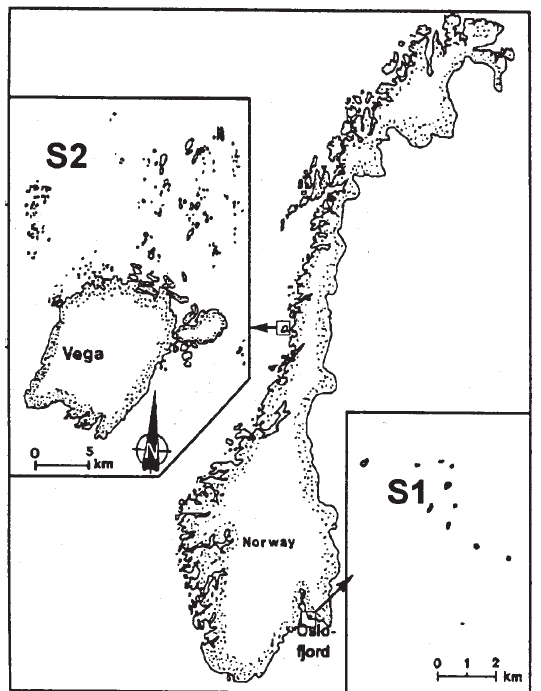
Fig. 2 . Sampling sites at Hvaler in the eastern outer Oslo- fjord (S1) and Vega in Nordland, northern Norway (S2).